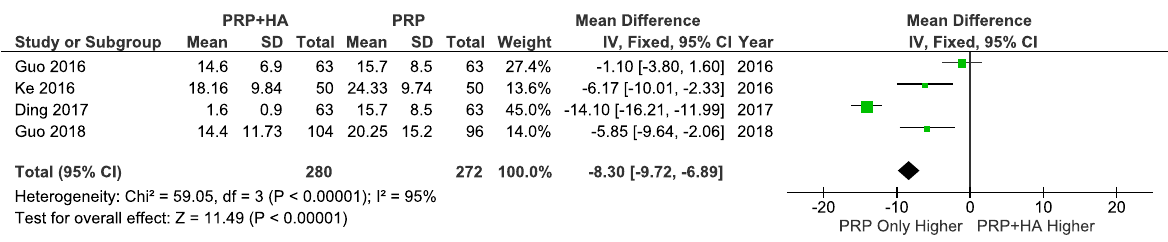
HA and PRP at 12 months after treatment +